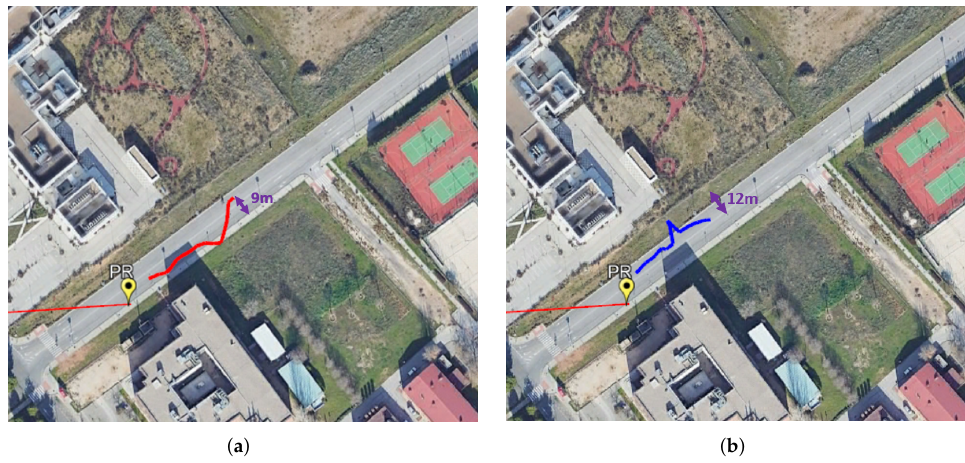
Figure 14. Localization results for non-cooperative targets moving away from PR location (blue and red). ( a ) First non-cooperative target. ( b ) Second non-cooperative target.